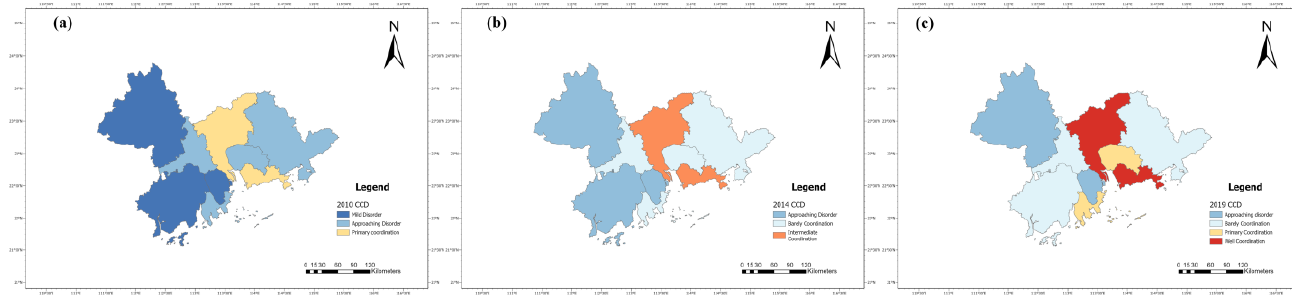
Figure 13. The CCD of the TEE system in the PRD in ( a ) 2010, ( b ) 2014, and ( c ) 2019.